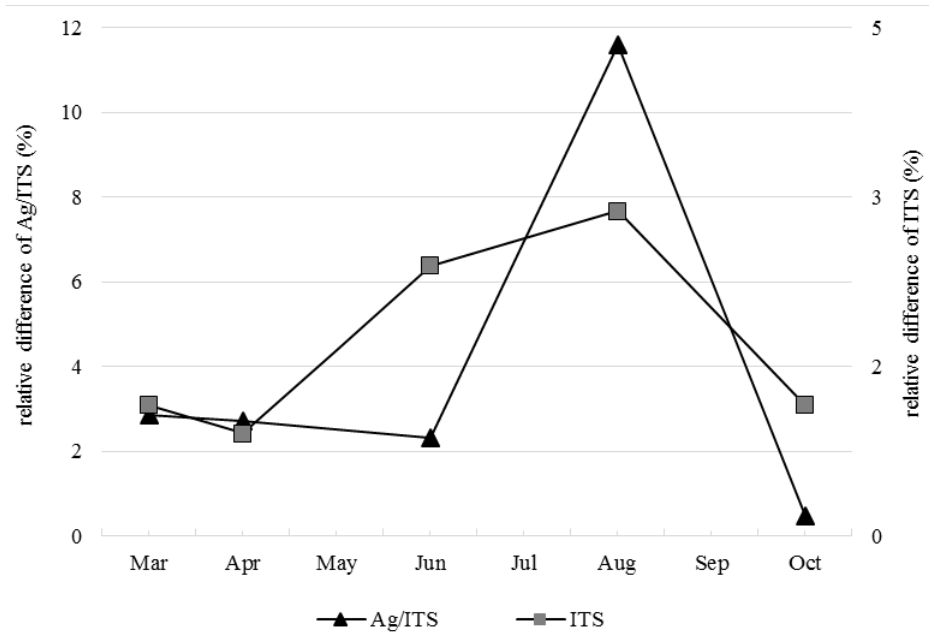
Figure 2. Relative differences (%) of proportion of Ag out of total fungal DNA (Ag/ITS) and total fungal DNA (ITS) between no-replant soil and replant soil.